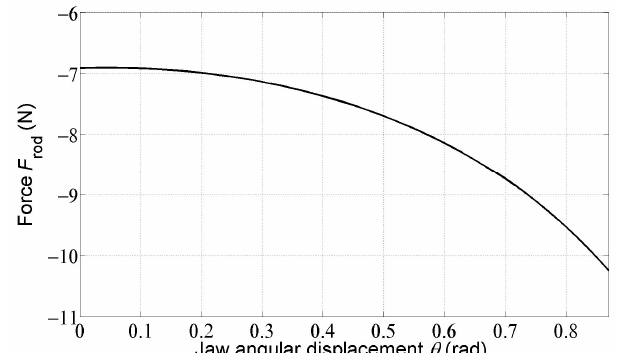
Figure 8. Dependence of the axial compression force in the connecting rod F rod on the jaw angular displacement θ .